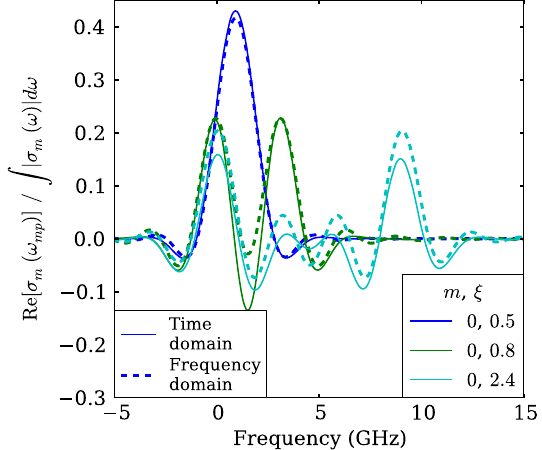
FIG. 12. Transverse bunch spectra in the flat potential condition for the m ¼ 0 mode at three different chromaticities. The frequency domain spectra are for the flattened bunch profile.